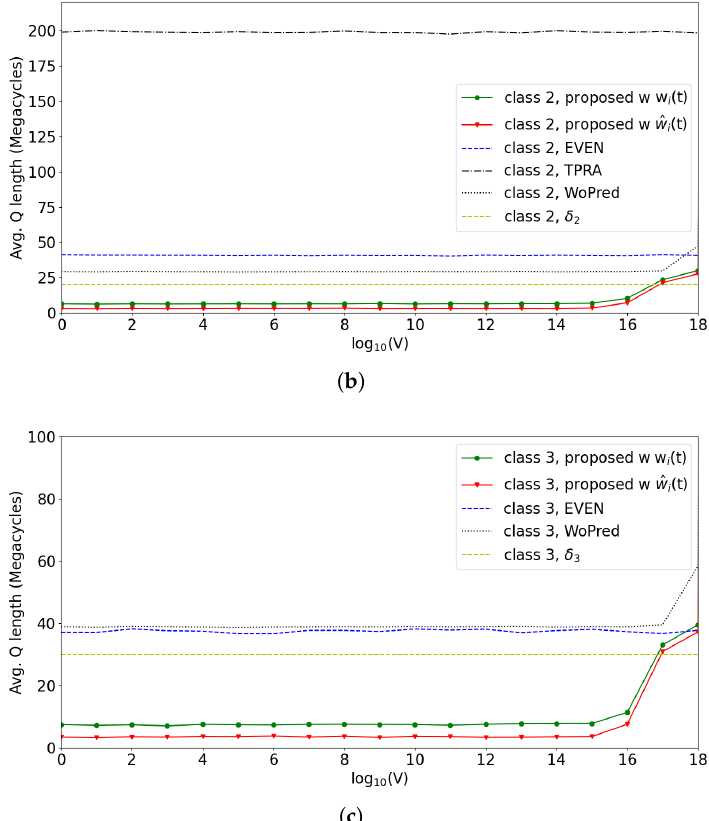
Figure 7. Average queue length with different V. The average length of the Class 3 queue obtained by TPRA is more than 2100 megacycles, which is much larger than those achieved by other methods. Therefore, in Figure 7c, we omit the case when TPRA is applied to show the differences among the other methods visually. ( a ) Class 1, ( b ) Class 2, and ( c ) Class